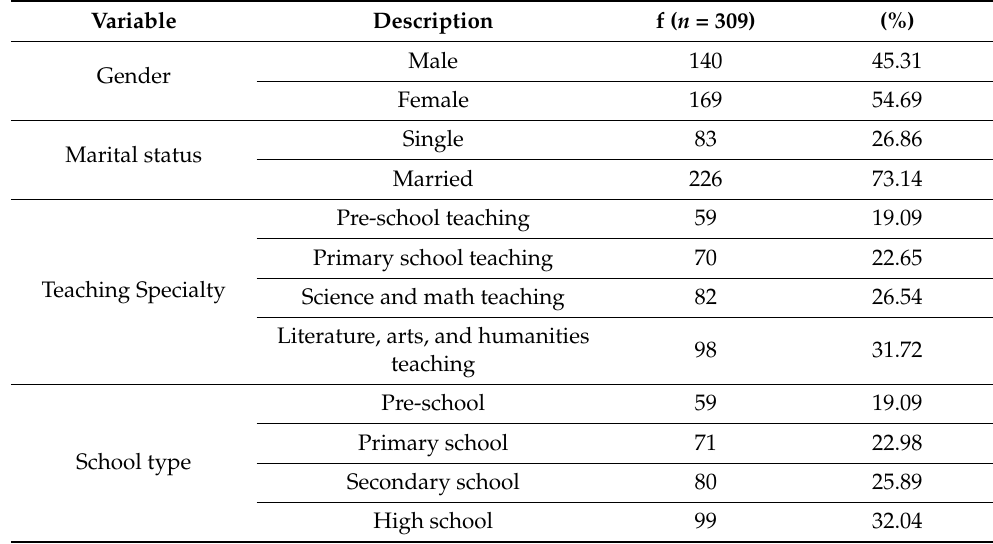
Table 1. The demographic characteristics of the participants.